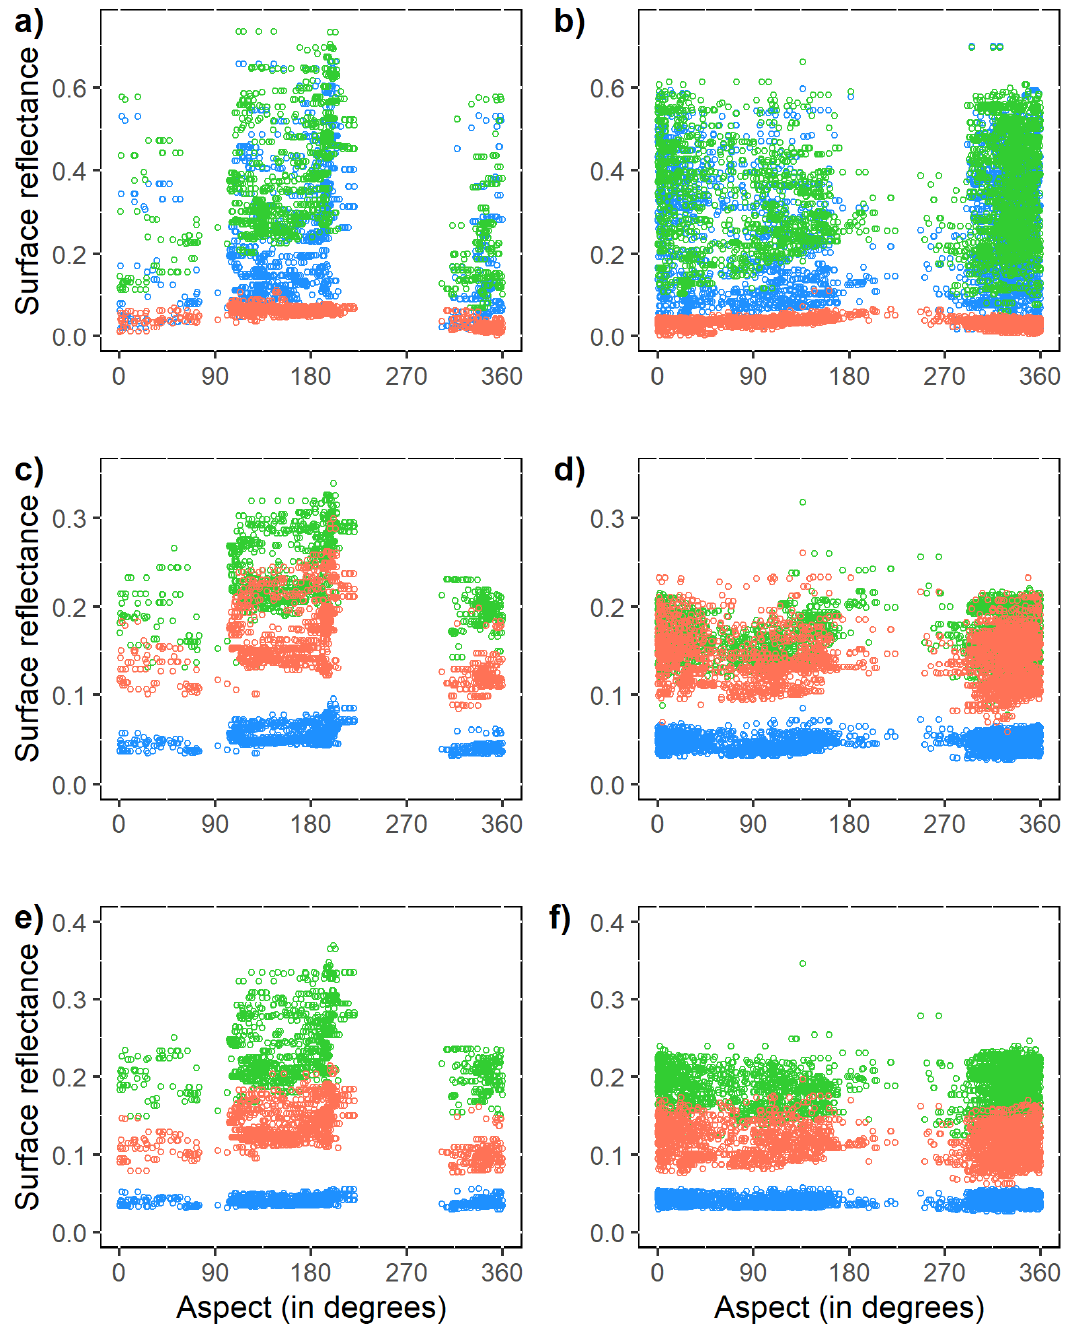
Figure 11. Relationships between surface reflectance (visible band in blue, near-infrared band in green, and shortwave infrared band in orange) and topographic aspects in March (upper panel), May (middle panel), and August (lower panel) 2014. Sub-plot ( a , c , e ) are for deciduous forests, while sub-plot ( b , d , f ) are for evergreen forests.